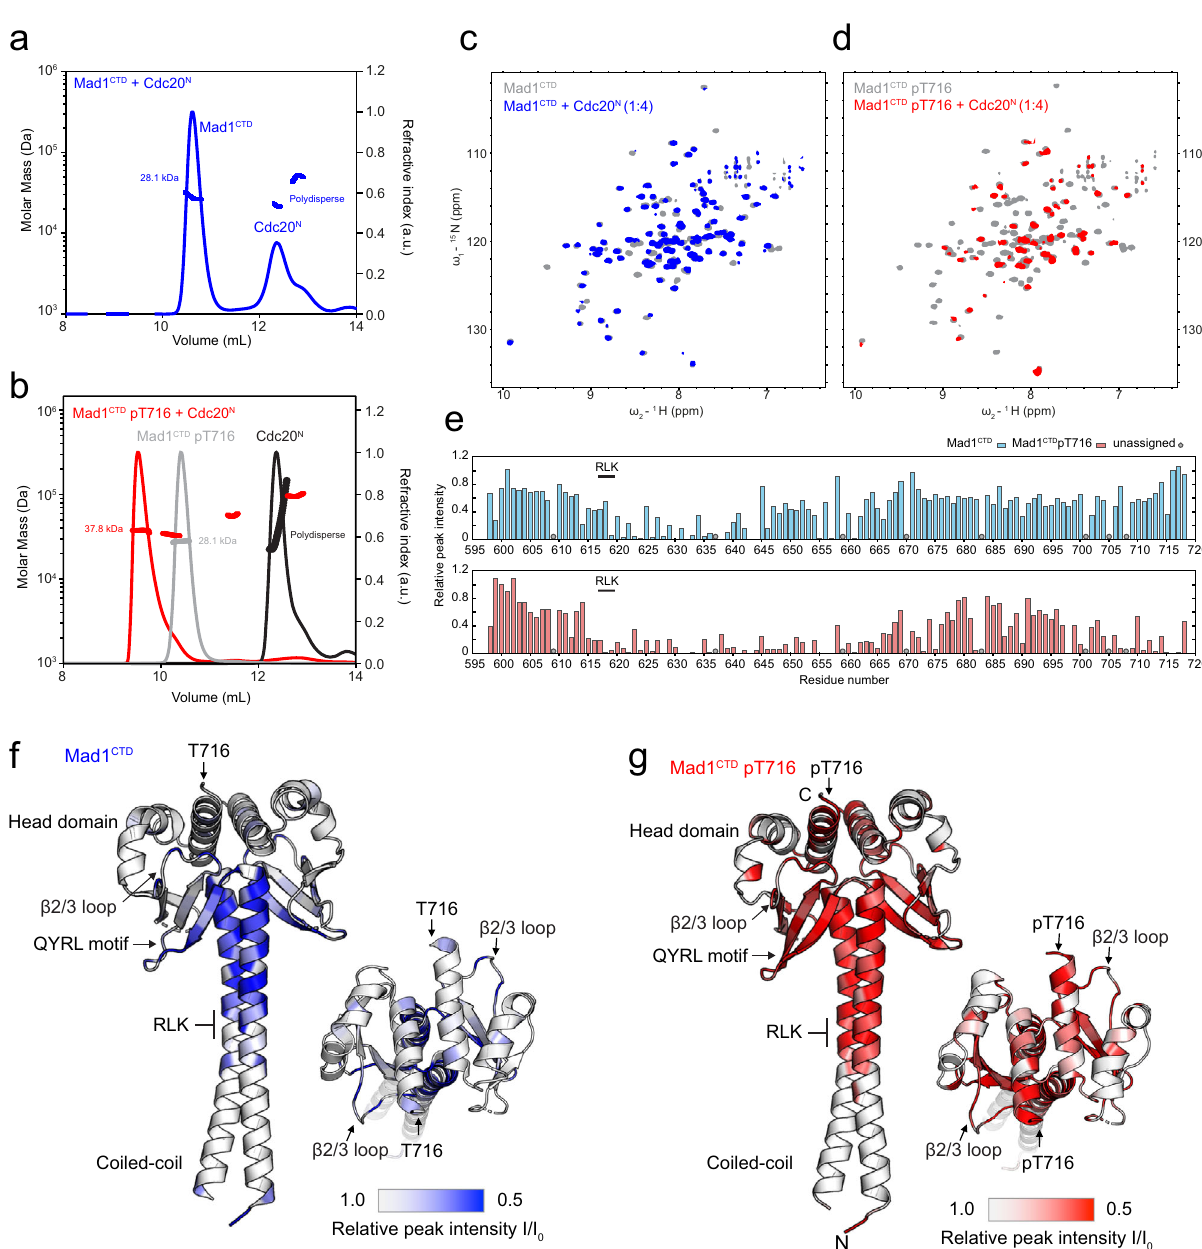
Fig. 2 | A direct Cdc20-Mad1 interaction mediated by phosphorylated Mad1 CTD pThr716. a SEC-MALS analysis of unphosphorylated Mad1 CTD +Cdc20 N (blue). The fi rst elution peak consists of free Mad1 CTD (expected mass 28kDa), while Cdc20 N (expected mass 7.8kDa) alone elutes in the second polydispersed peak (later con fi rmed to be homogenous monomer by AUC-SE in Supplementary Fig. 2), suggesting there is no binding between unphosphorylated Mad1 CTD and Cdc20 N . b SEC-MALSanalysisoffreeMad1 CTD pT716(grey),freeCdc20 N (black)andMad1 CTD pT716+Cdc20 N (red). Mad1 CTD pT716 alone (grey) eluted as one monodispersed species with an apparent mass of 28.1kDa. Cdc20 N alone (black) elutes as a poly- dispersed peak with an unde fi ned mass. Mad1 CTD pT716+Cdc20 N (red) gives a distinctmonodispersedspeciesof37.8kDa,indicativeofastablecomplexwithone Mad1 CTD pT716 dimer and a single molecule of Cdc20 N (expected 36kDa). c 1 H, 15 N 2D HSQC showing 15 N-labelled unphosphorylated Mad1 CTD alone (grey) or in the presenceoffourmolarexcessCdc20 N (blue). d 1 H, 15 N2DHSQCshowing 15 N-labelled